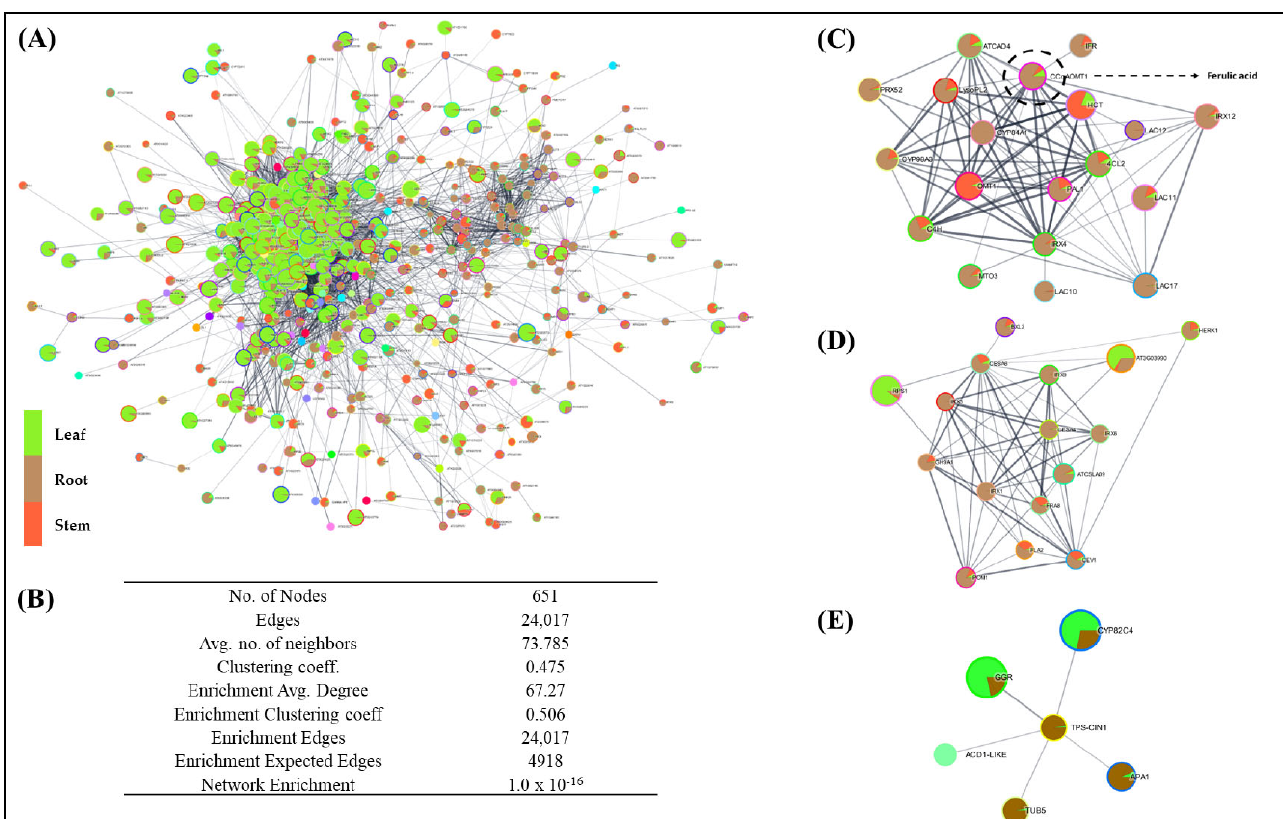
Figure 4. ( A ) Predicted spatial transcriptional interactome of A. glauca . ( B ) Network statistics of the interactome build. ( C ) Enriched network of ferulic acid pathway. ( D , E ) Terpenoid biosynthesis. The green color represents significant enrichment in the leaf tissue, orange in the stem tissue, and brown in the root tissue.